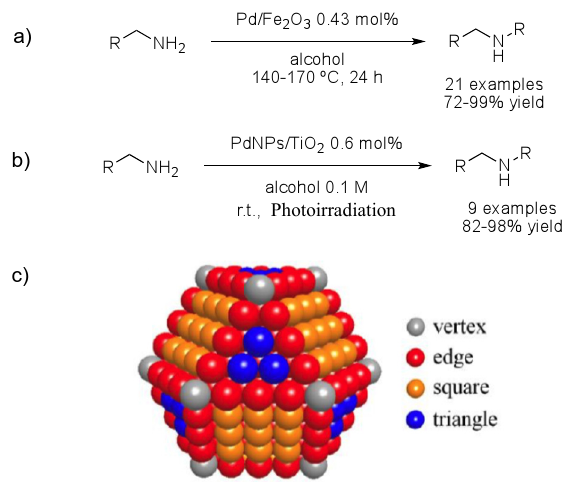
Figure 4. Tandem oxidation/condensation/reduction over PdNPs/Fe 2 O 3 ( a ) [43] and PdNPs/TiO 2 ( b ) [44]. Different types of atoms in a fcc nanoparticle ( c ). Reproduced from [56] with permission from the American Chemical Society.